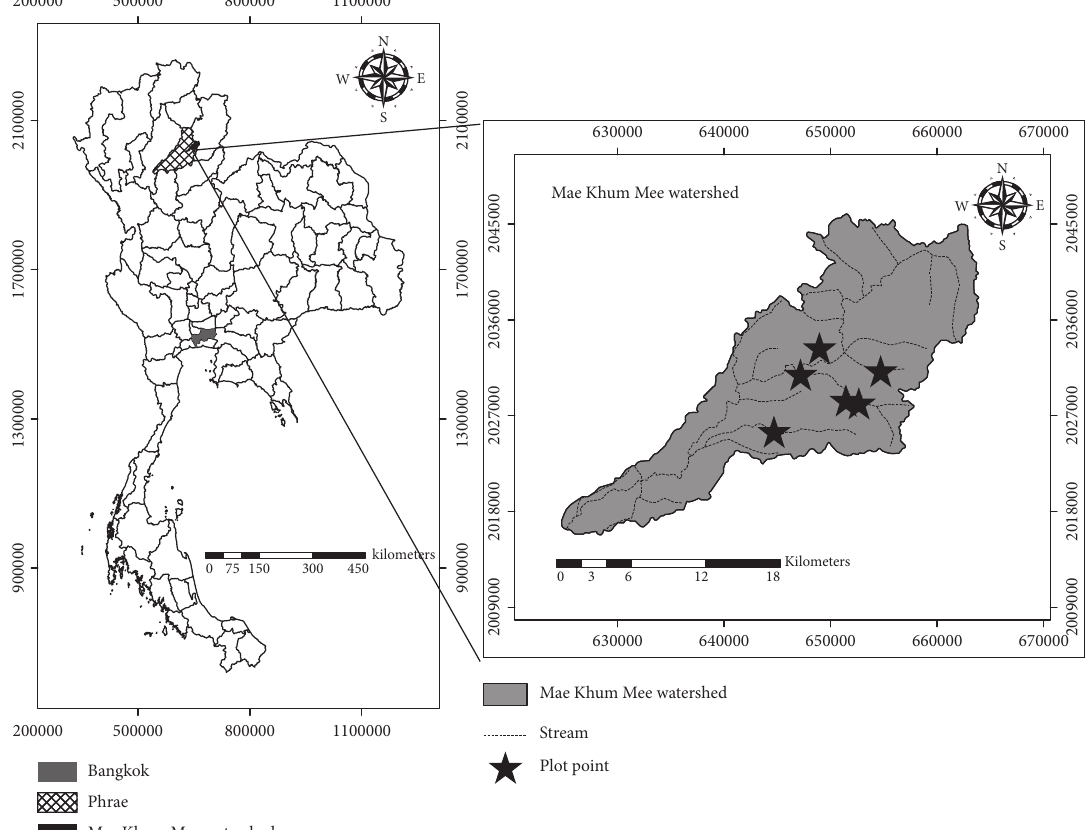
Figure 1: Locations of the Mae Khum Mee subwatershed and study sites in Phrae Province, northern